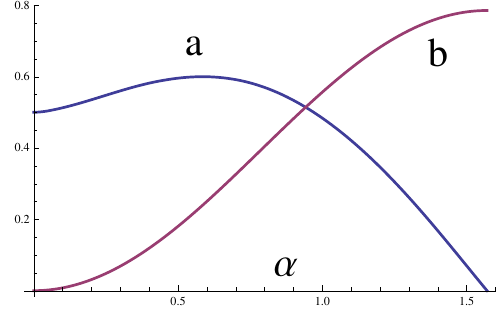
Figure 11 . The plot of a 0 (blue) and b 0 (red) as a function of (cid:11)